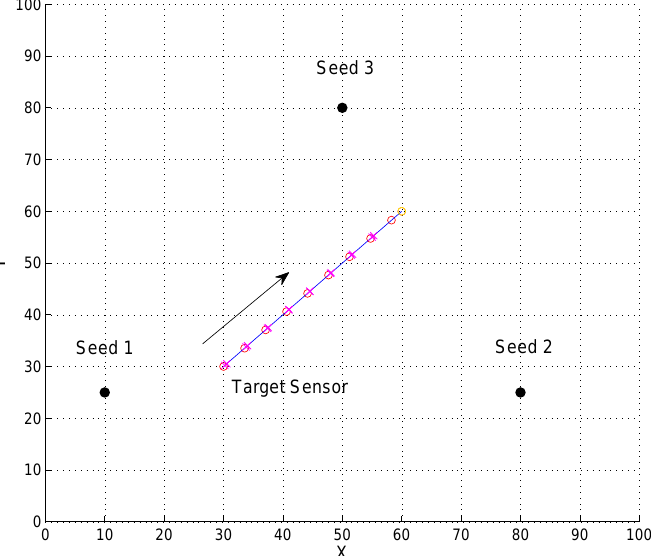
Figure 8. The mobility model of the target